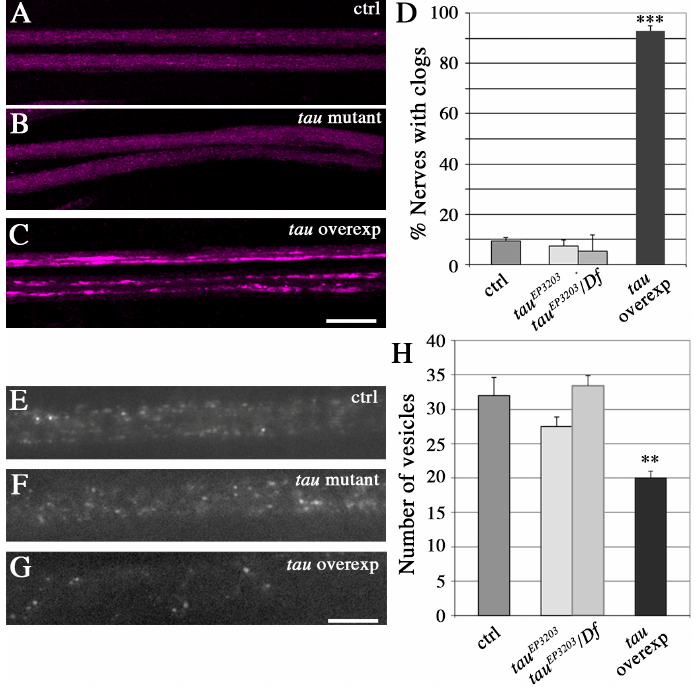
Figure 4. Effect of Tau depletion or excess on vesicle localization and density in axons. ( A – C ) Immunolabeling of vesicles with the anti-CSP (Cystein String Protein) antibody (Magenta) shows a massive presence of accumulations of vesicles, detected as intense fluorescent patches, in segmental nerves of tau overexpressing larvae, but no change of vesicle localization in tau mutants ( tau ep3203 mutant larvae). Scale bar is 25 μ m. ( D ) Quantification of the relative number of nerves with vesicular accumulations (batches of vesicles) in different genotypes. The histogram shows a mean of 9.4 ± 1.5% of segmental nerves with accumulations of vesicles in control larvae ( n = 20 larvae); 7.3 ± 2.4% of nerves with accumulations of vesicles ( n = 21; non significant) in tau ep3203 mutant larvae; 5.5 ± 6.2% of nerves with accumulations of vesicles ( n = 9, ns) in tau ep3203 /Df(3R)BSC498 mutant larvae and 92.9 ± 2.5% of nerves with accumulations of vesicles ( n = 12, p < 0.001) in tau -overexpressing larvae. Hence, only tau -overexpressing larvae display a significant increase in the number of accumulations of vesicles. Values are means +/ − SEM. *** p < 0.001 (Student’s t -test), ns means non-significant. ( E – G ) In vivo visualization of vesicle density in segmental nerves by expressing the vesicular marker NPY-GFP in motoneurones shows a decreased density of vesicles only in tau -overexpressing larvae. In this last genotype, an image of a section of the segmental nerve without any batch of vesicles is shown (so that the higher intensity of these batches does not prevent from counting and visualizing of vesicles). Scale bar is 10 μ m. ( F ) Quantification of the number of vesicles within a fixed nerve length (20 μ m) in control flies, tau mutants, and tau -overexpressing flies. Only tau -overexpressing flies display a significant decrease in the number of “individual” vesicles (i.e., vesicles that are not stuck in batches). Only areas of nerves without accumulation of vesicles (the accumulation being upstream and downstream in the nerves) were selected for the counting of isolated vesicles in tau -overexpressing flies. Values are means +/ − SEM. * p < 0.05 (Student’s t -test).